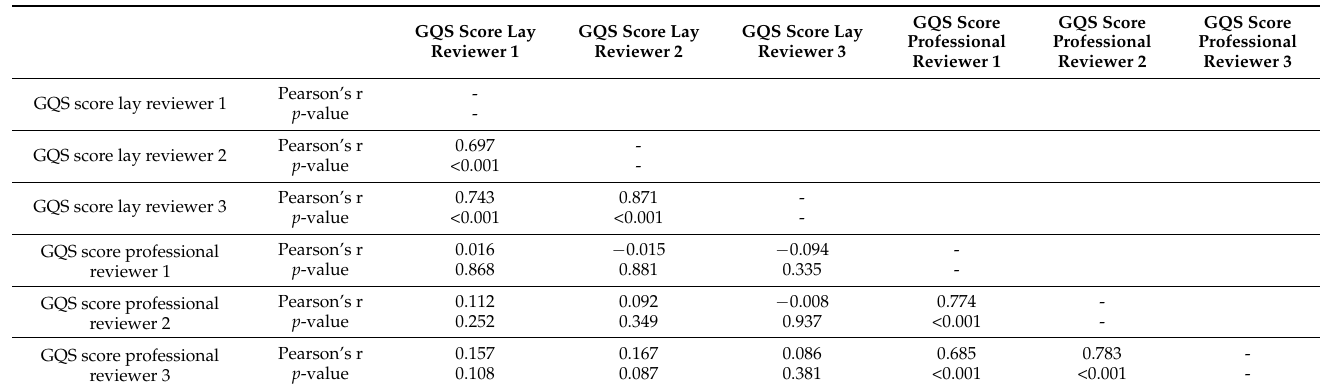
Table 4. Correlation analysis between the GQS scores of the six reviewers.